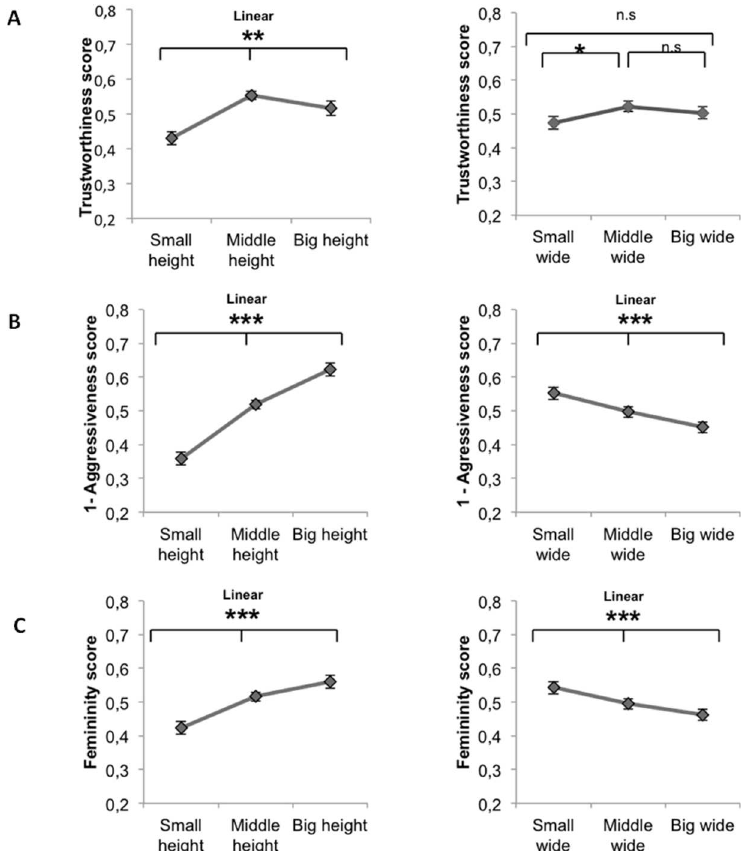
Fig 3. (A-B-C) Average score for trustworthiness, femininity and aggressiveness judgements in all visual conditions. Left panels: result for the vertical component (Small-Middle-Big Height faces); right panels:results for the horizontalcomponent(Small-Middle-BigWide faces). Because aggressiveness judgments are negatively correlatedto trustworthiness and femininityjudgements, values reportedare 1-Aggressiveness values to clarify the effect across experiments. This transformation does not make statistical